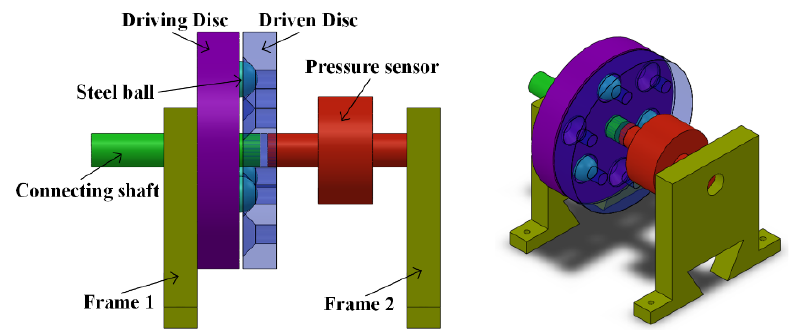
Figure 19. Schematic diagram of experimental set up.